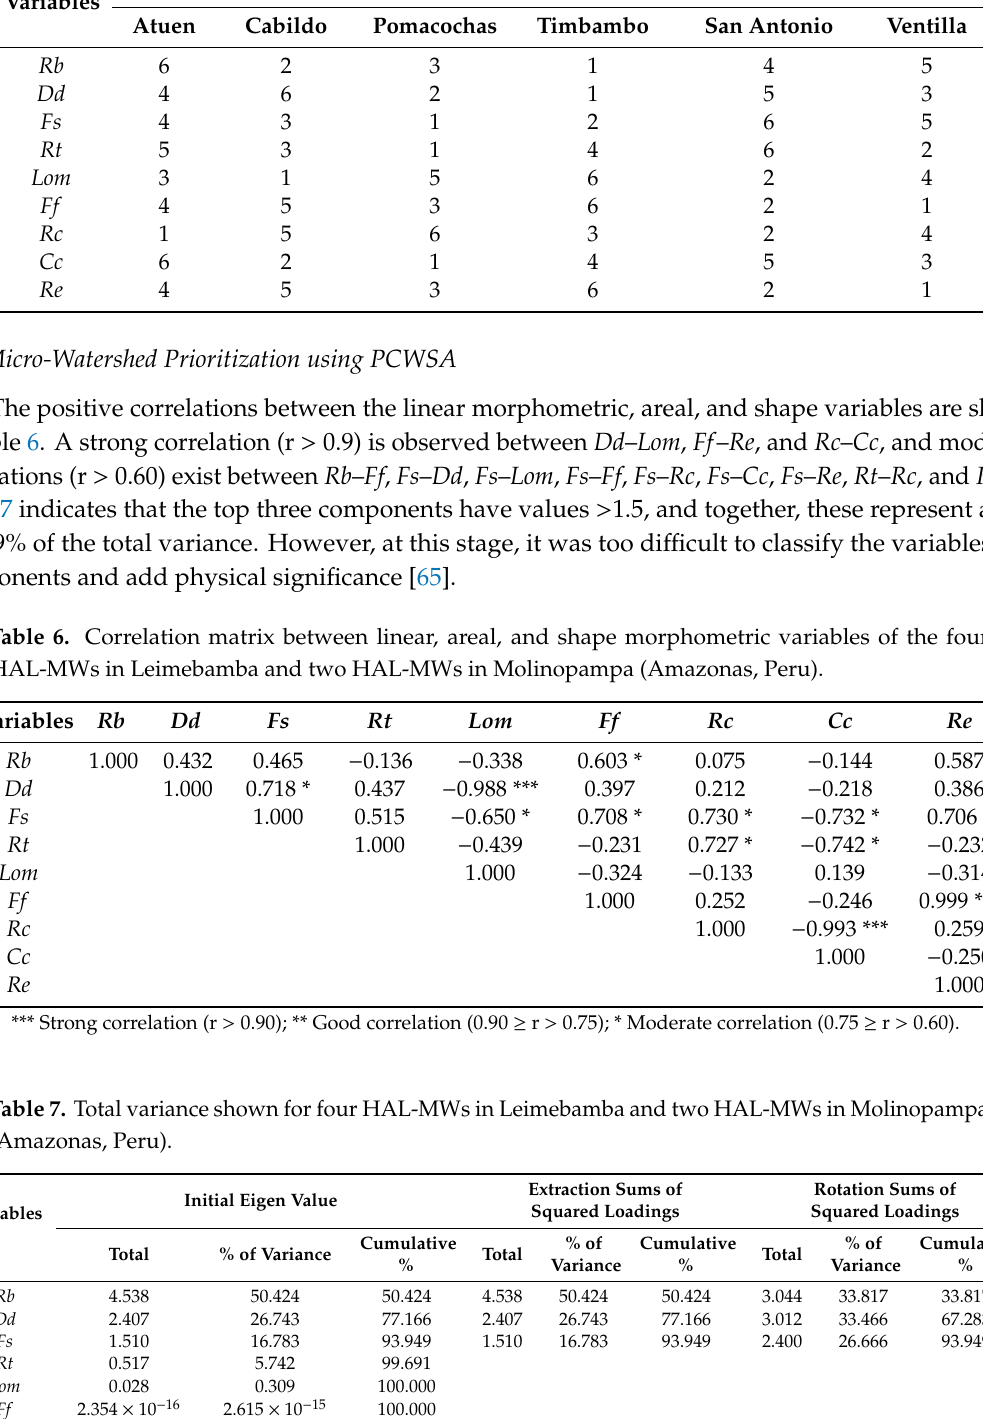
Table 5. Preliminary Priority Rank (PPR) based on linear, areal, and shape variables of the four HAL-MWs in Leimebamba and two HAL-MWs in Molinopampa (Amazonas, Peru). Leimebamba Variables